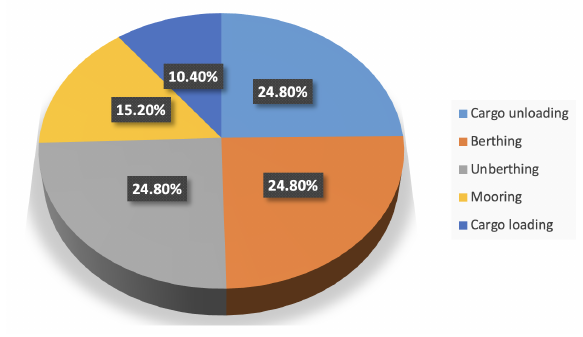
Fig. 2. The weights of basic ship